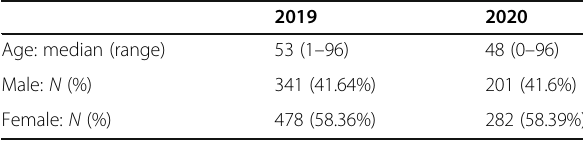
Table 2 Patient ’ s demographic data